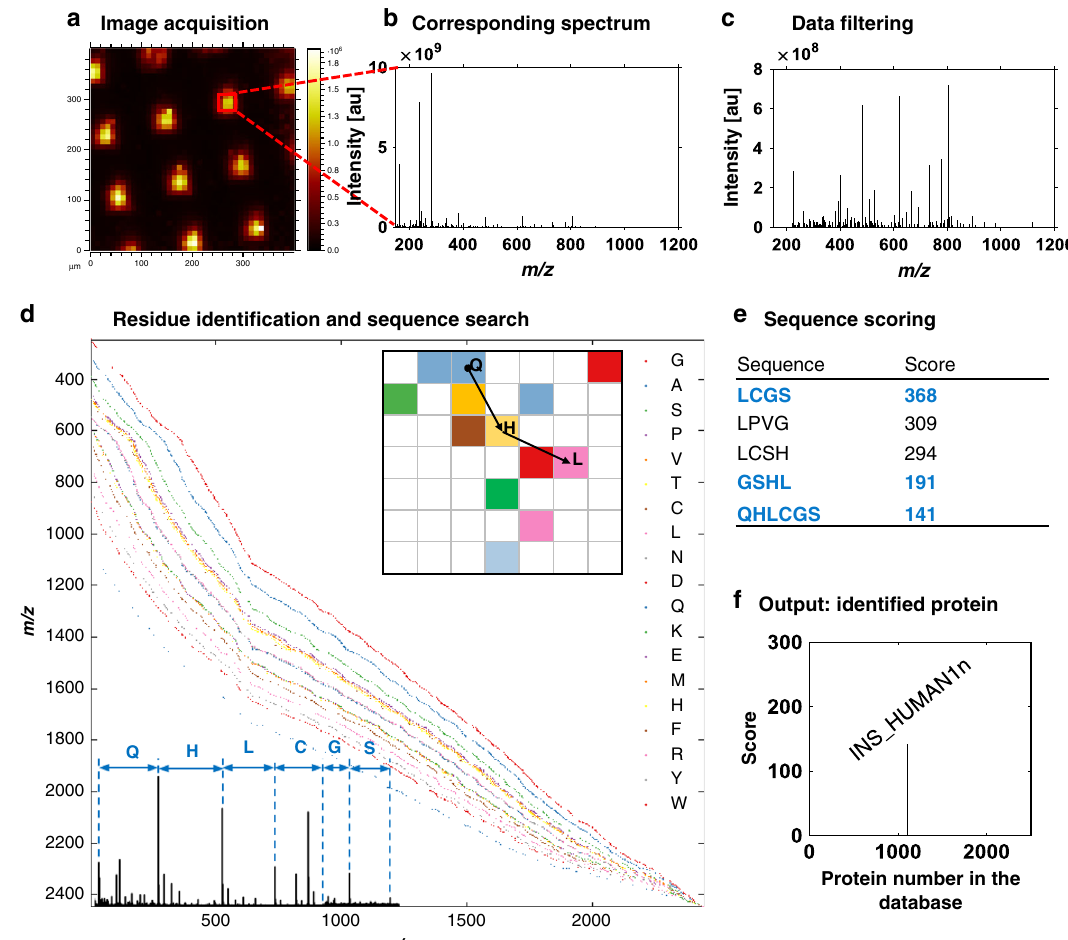
Fig. 3 Work fl ow for automated protein identi fi cation directly from a surface. a Secondary ion image of an example protein. b Acquired spectrum from protein region. c The data requires processing consisting of chemical and intensity fi ltering. d The script detects amino acid neutral losses and continuous sequences in the processed spectra. e Detected sequences are scored against the UniProt database. f Possible proteins are presented in the graphical output to assess